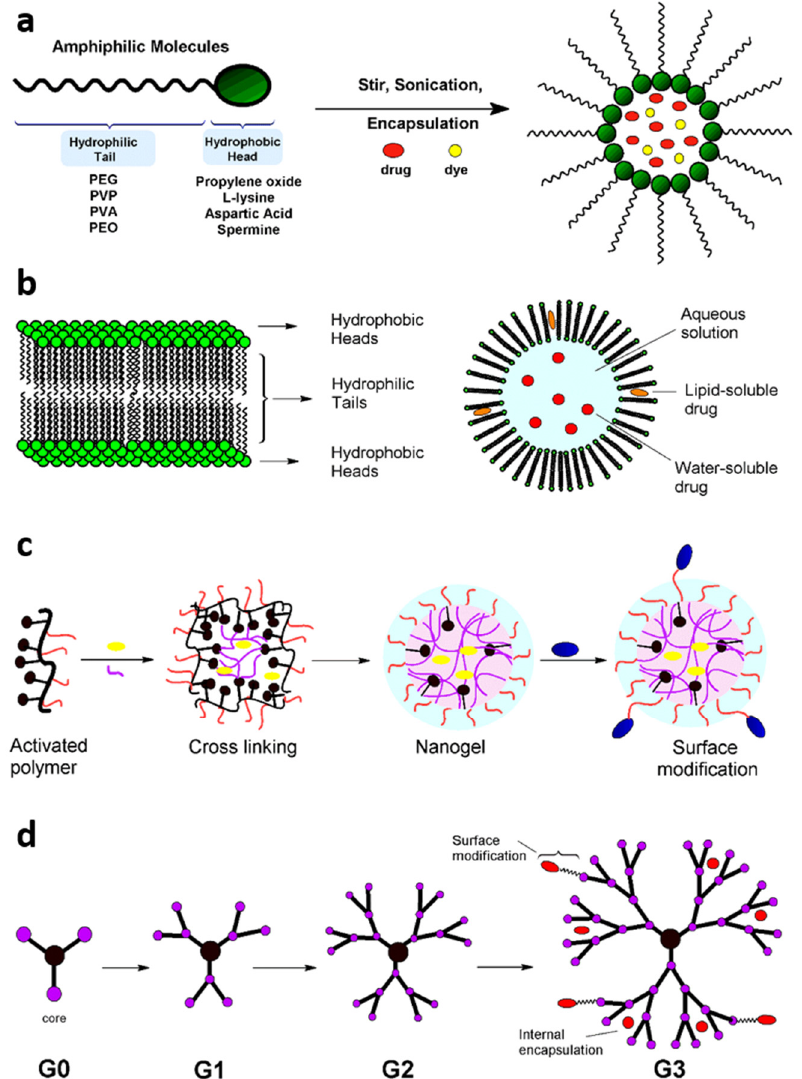
Figure 3. Organic nanoparticles (NPs): nanomicelles, liposomes, nanogels and dendrimers. ( a ) Nanomicelles are constructed by the assembly of amphiphilic blocks with a hydrophobic head and a hydrophilic outer tail. Imaging and treatment agents are encapsulated inside the hydrophobic core; ( b ) Liposome NPs are made up of lipid bilayers that carry drug inside the hydrophobic core or inside the lipid bilayer; ( c ) Polymeric nanogels are synthesized by crosslinking activated polymer chains, creating an inner porous space that can accommodate multiple payloads and imaging moieties; ( d ) Dendrimers are highly branched polymers that are synthesized by repeated branching cycles. The inner core and the outer branches provide multiple points of conjugation of imaging, targeting and treatment